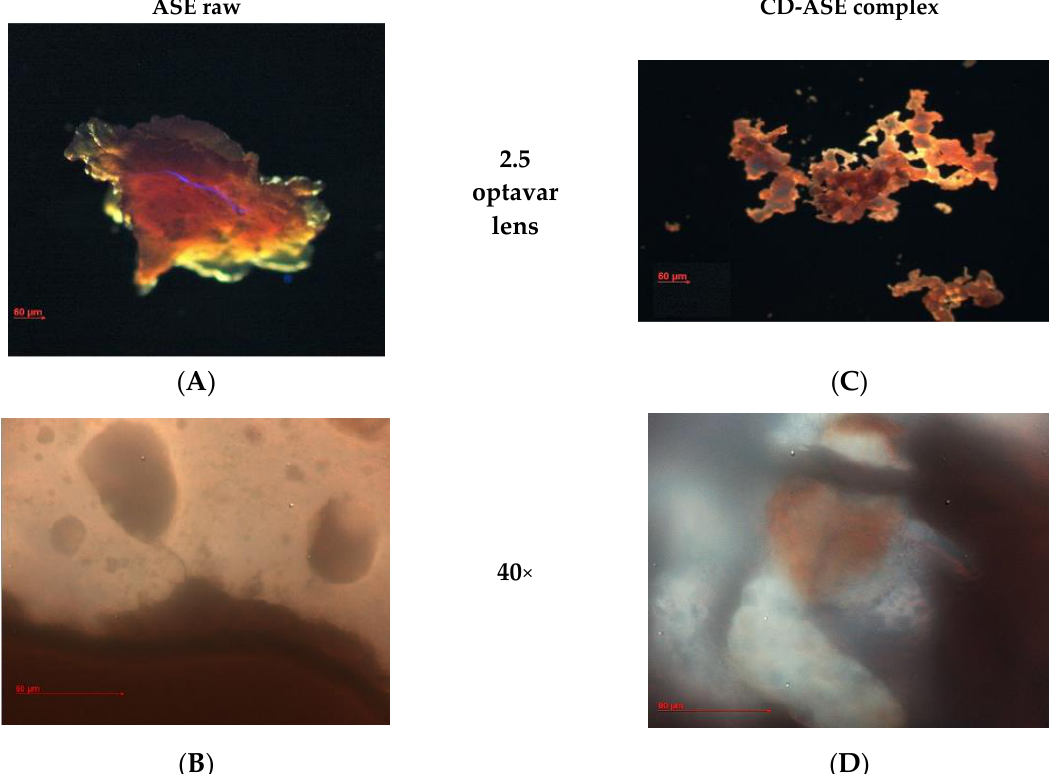
Figure 5. Fluorescence (FM, optical 2.5 and ×40) microphotographs of ASE raw ( A , B ) and ASE-CD complex ( C , D ).